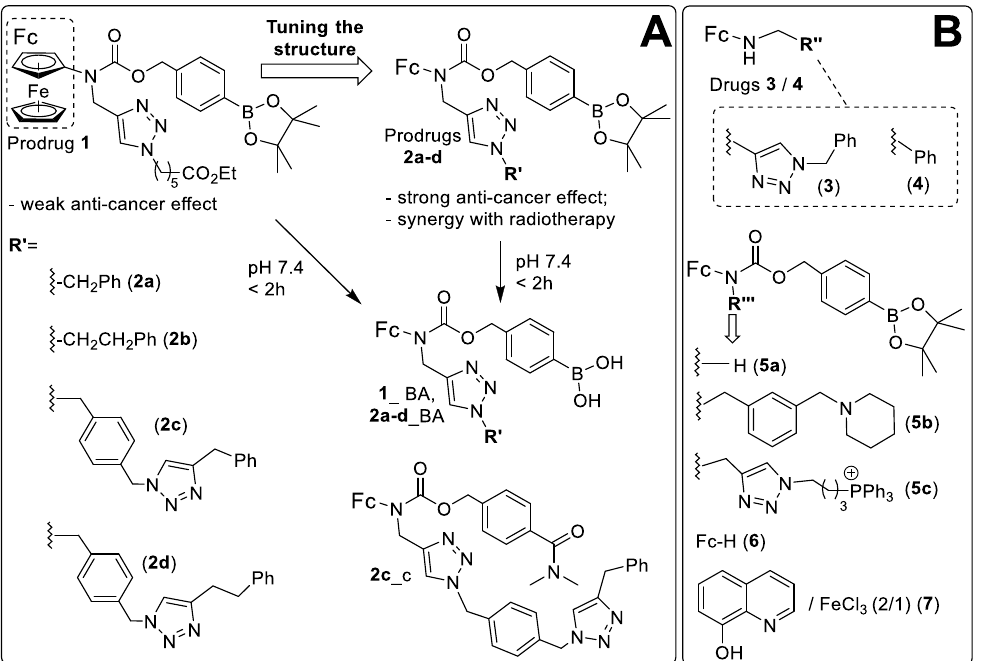
Figure 1. ( A ) Structures of the known prodrug 1 [21,24], its derivatives 2a-d and hydrolyzed at pH 7.4 forms of the prodrugs (1_BA, 2a_d_BA) as well as control 2c_c. ( B ) Structures of representative NAAF drugs 3 and 4 as well as reference compounds used in this work.